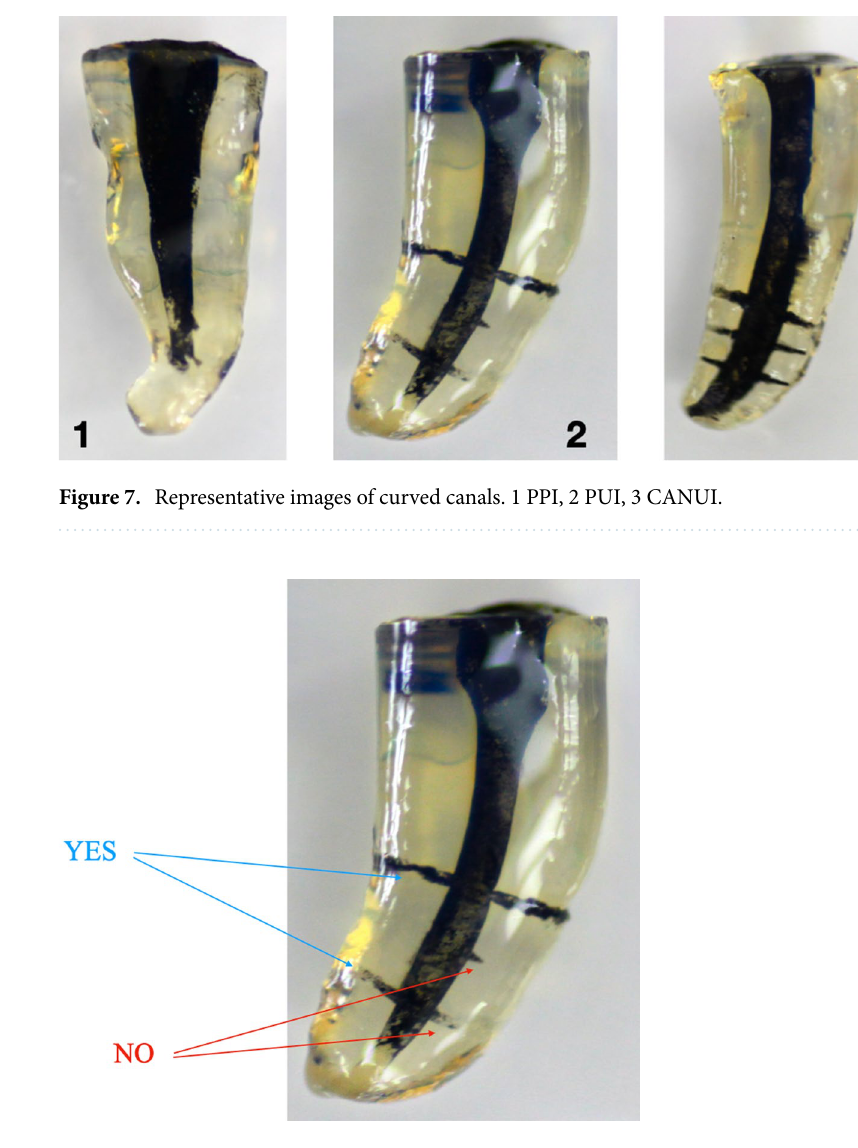
Figure 8. Evaluation criteria: Contrast solution penetrated to at least 50% of the total